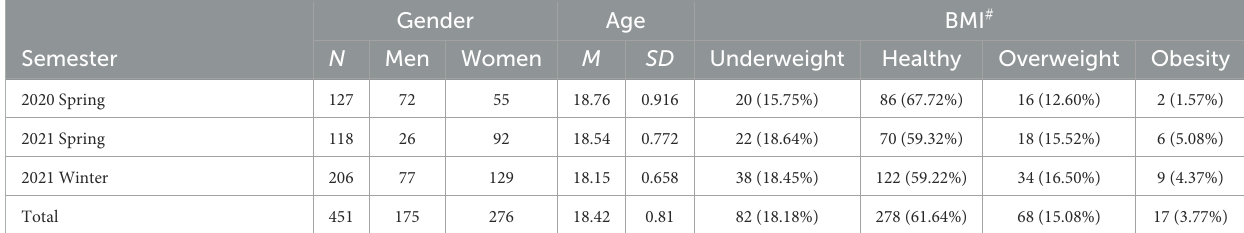
TABLE 1 Descriptive statistics of samples.